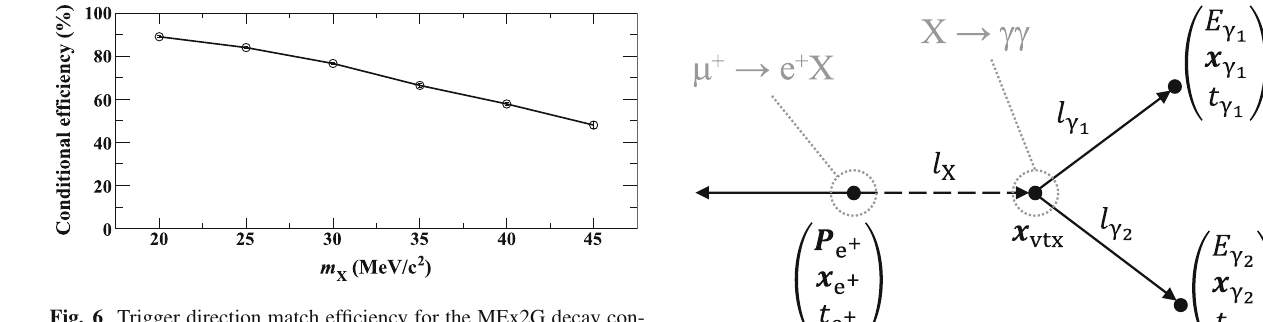
Fig. 6 Trigger direction match efficiency for the MEx2G decay con- ditional to e + and 2 γ detection as a function of m X evaluated with a Monte Carlo simulation (Sect. 4)